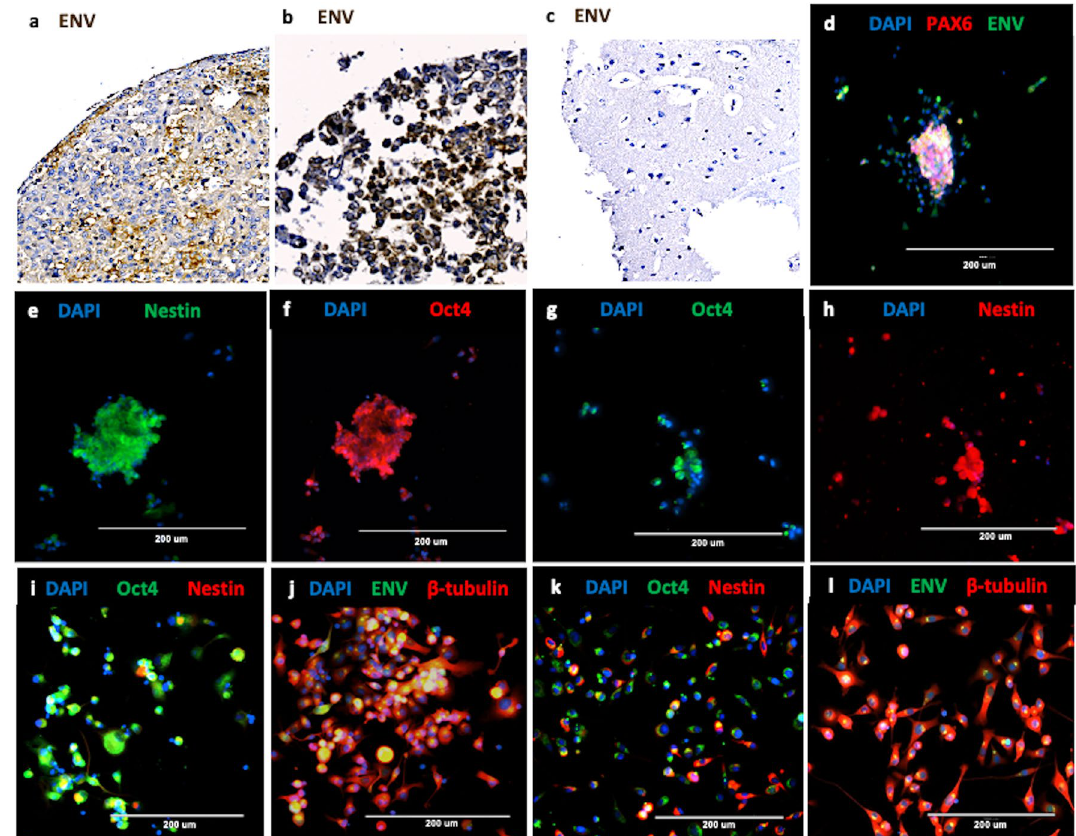
Figure 1. Immunostaining and Immunohistochemistry of patient-derived AT/RT cells and tissues. ( a , b ) Two resected patient AT/RT demonstrate strong immunostaining with HML-2 Envelope (Env) monoclonal antibody (brown). ( c ) Cerebrum from a normal brain is negative when stained with the same antibody. ( d – l ) AT/RT cell lines express markers of multiple stages of differentiation; representative images are shown. ( d ) CHLA 02, a patient derived AT/RT cell line, expresses Pax6 (red), a marker for neuroectoderm, merged with immunostaining for HML-2 Env (green). ( e ) : This cell line also expresses Nestin (green), a marker of neural stem cells. ( f ) The same cell line expresses Oct4 (red), a pluripotency marker. ( g , h ) CHLA 04 cells, another AT/ RT line, express Oct4 (green) and Nestin (red). ( i ) CHLA 05 cells also express Oct4 (green) and Nestin (red). ( j ) The same cell line also expresses βIII tubulin (red), a marker for neurons and HML-2 envelope (green). ( k ) CHLA 06 cells also express Nestin (red) and Oct4 (green). ( l ) The same cell line also expresses βIII tubulin (red) and HML-2 Env (green). Nuclei are stained with DAPI (blue). For IHC images, slides were scanned with a OptraScan Digital Pathology Scanner and processed in Adobe Photoshop for incorporation into the figure. For immunofluorescent images, an EVOS fluorescence microscope (AMG) was used. Images were acquired with the native software installed on the EVOS microscope and processed in Microsoft PowerPoint (https:// www. therm ofish er. com/ us/ en/ home/ techn ical- resou rces/ softw are- downl oads/ evos- fl- cell- imagi ng- system.